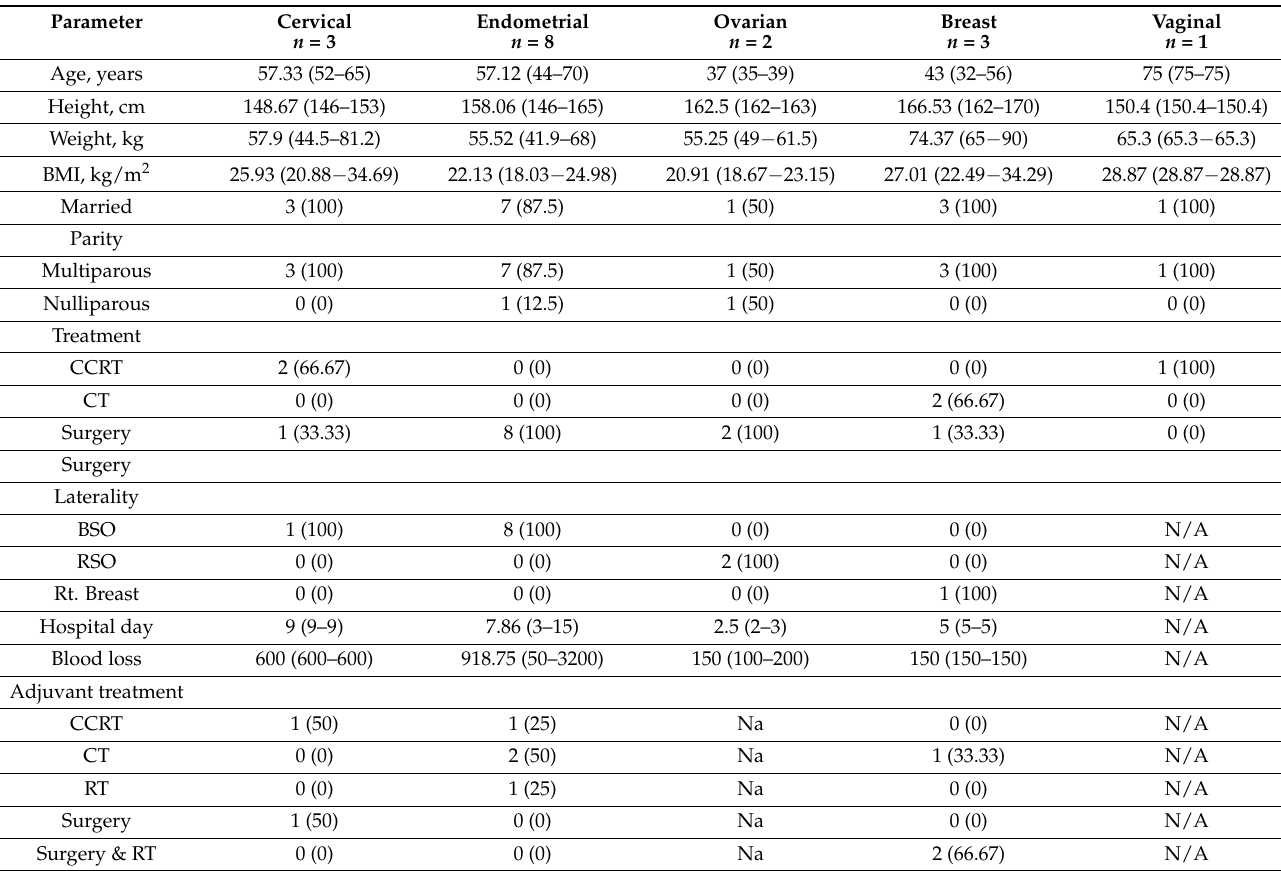
Table 2. Demographics of the study population.